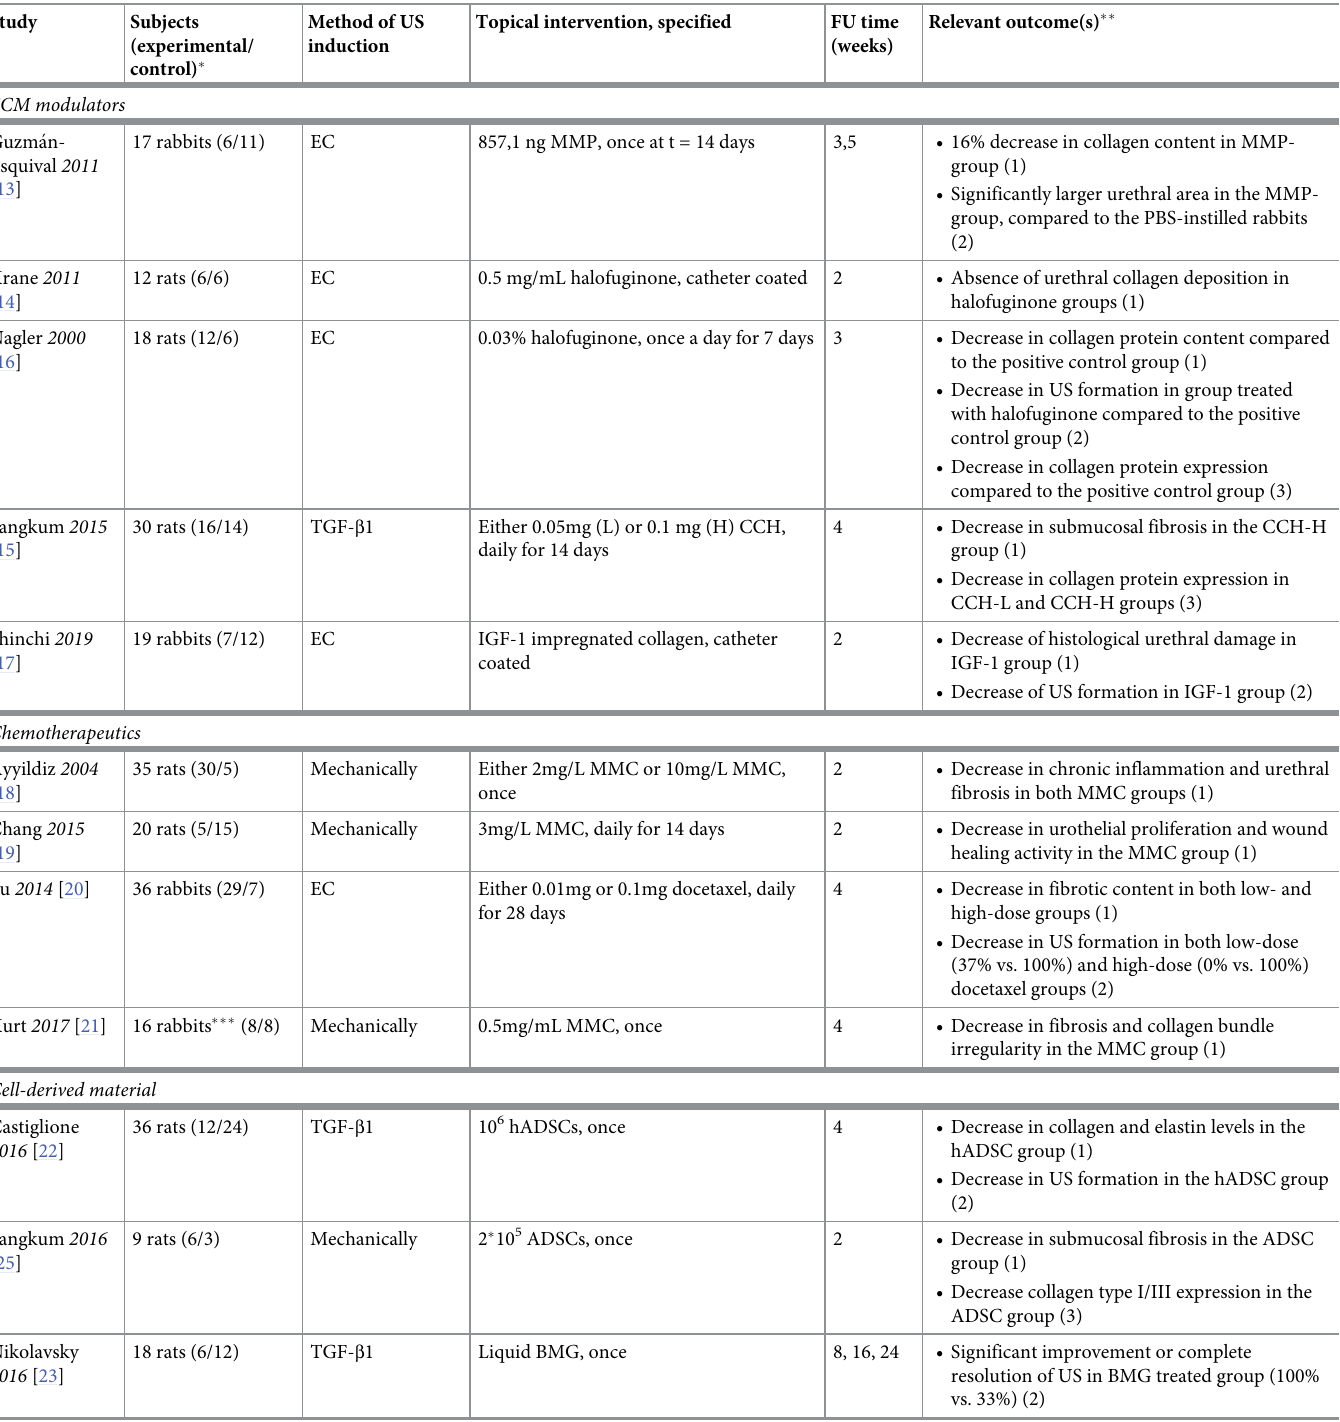
Table 1. Overview of preclinical study